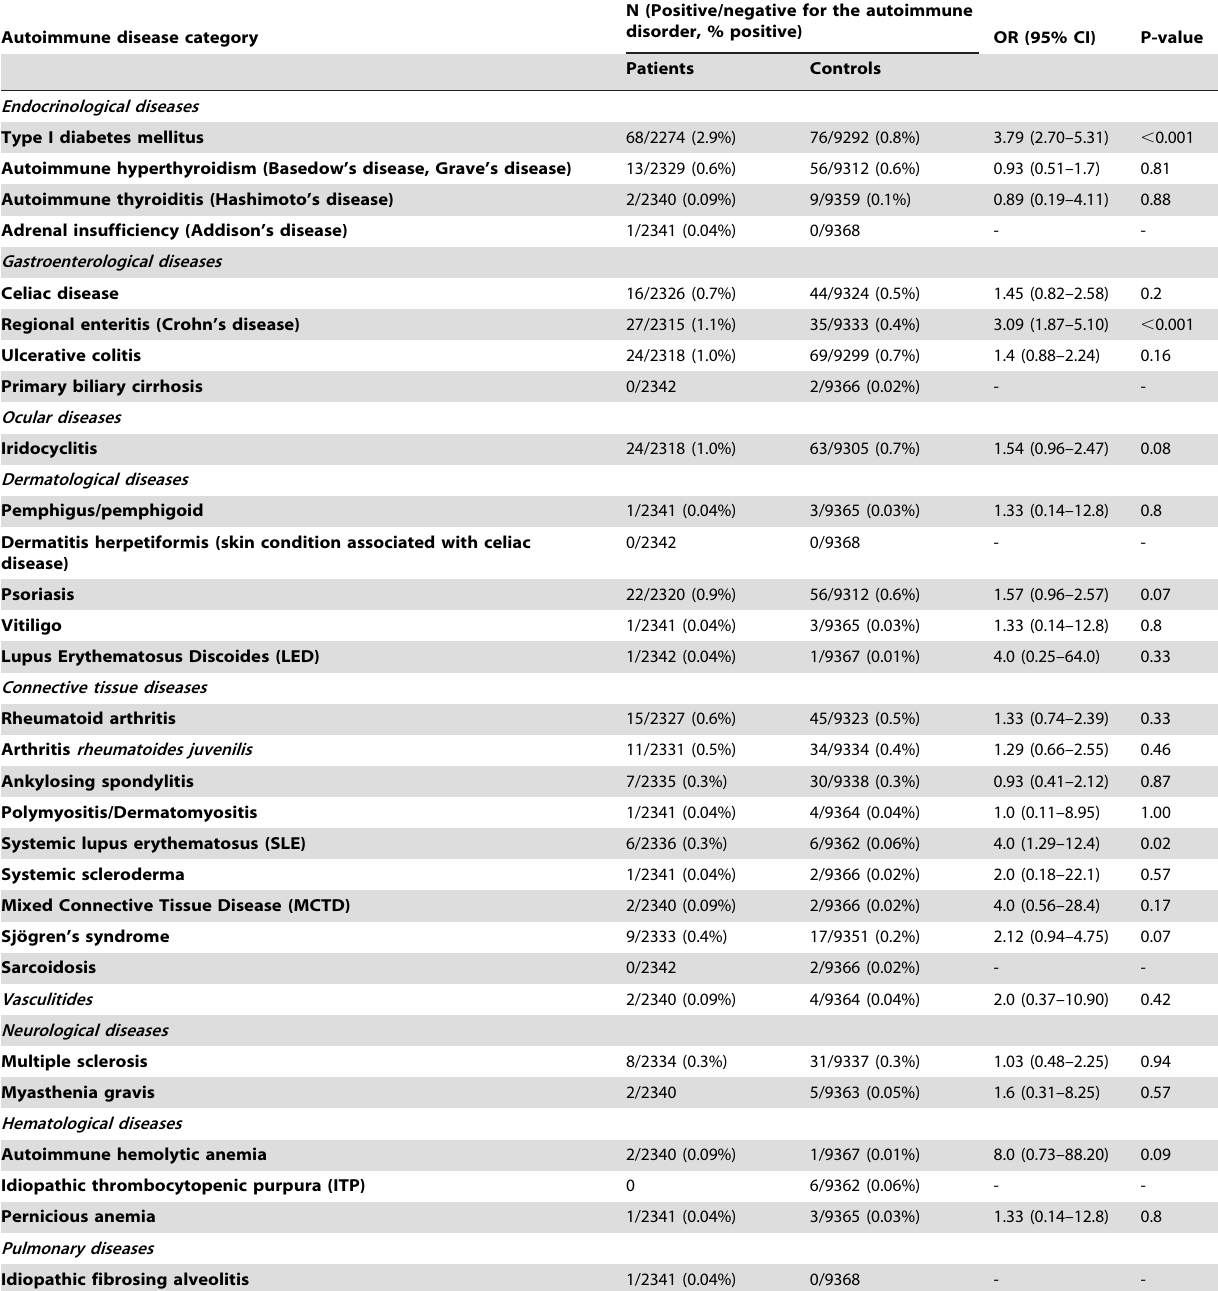
Table 5. Autoimmune disease status per each individual autoimmune disease included in the study at the end of the study period (covering the time before, during and after the treatment) for a composite of all patients with eating disorder compared with their control